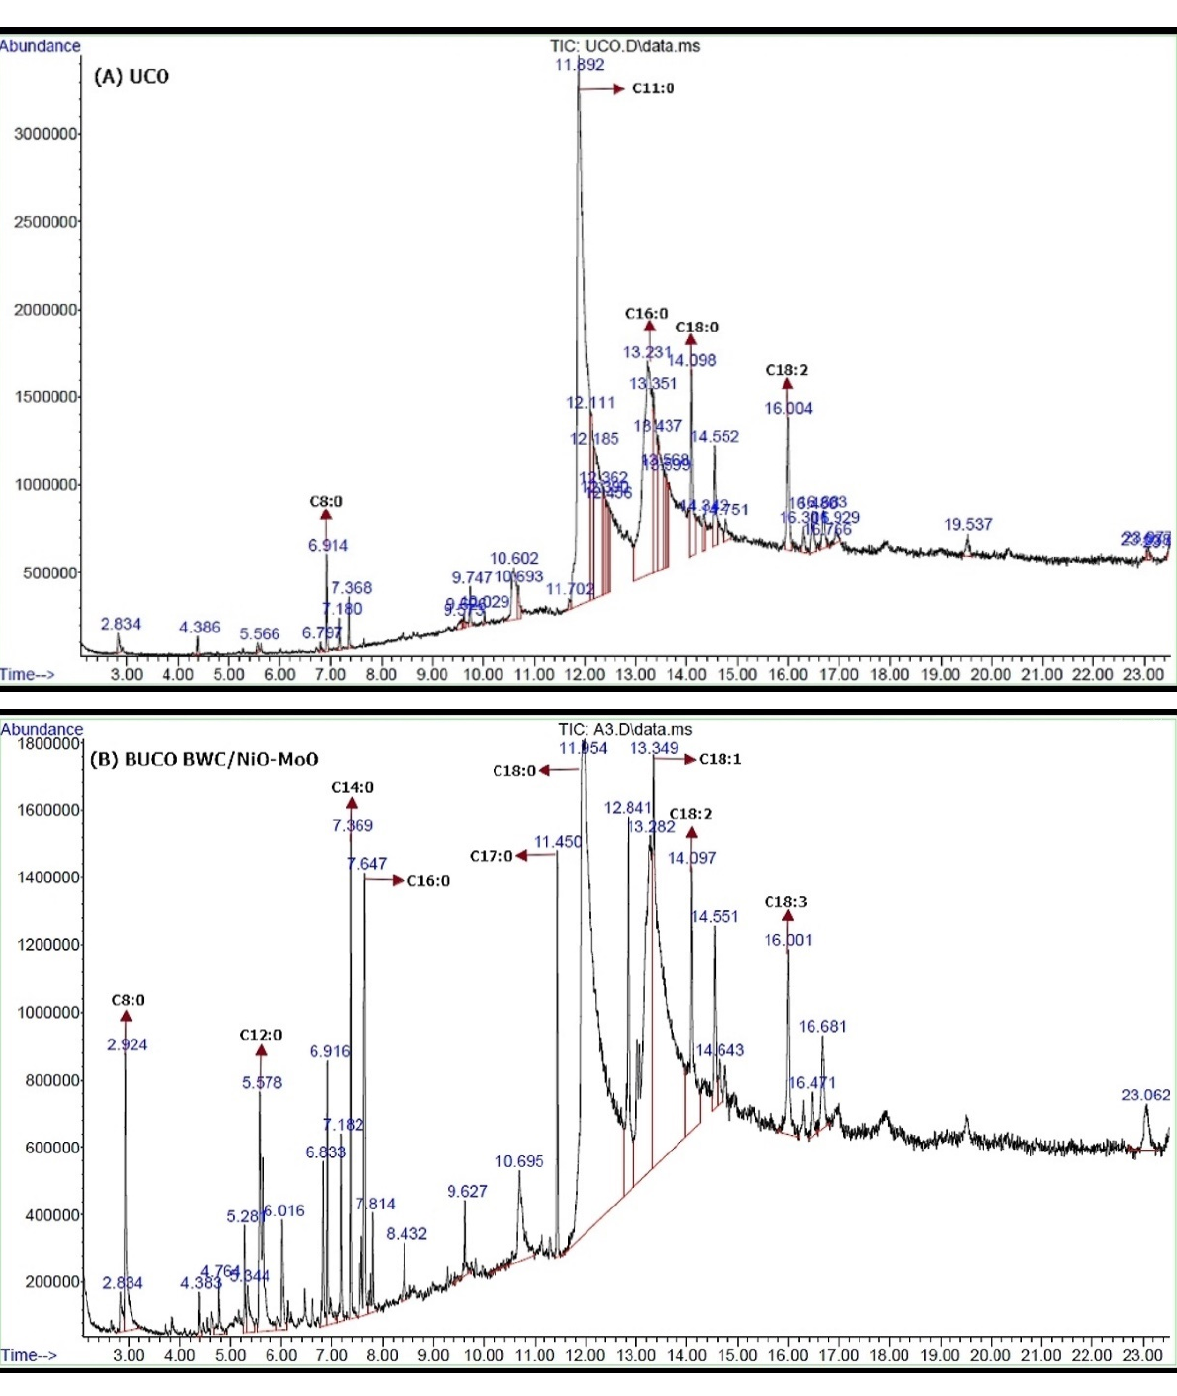
Figure 8. ( A ) Fatty acid profile for UCO, and ( B ) fatty acid profile for biodiesel using BWC/NiO-MoO. Mainly the primary methyl esters such as Octanoic acid (C8), Hexadecenoic acid, Octadecanoic, Oleic acid (C18), Heptadecanoic (C17), Dodecanoic (C12), Nonanoic (C9) acids, etc. were seen in biodiesel. In a similar study, biodiesel produced from waste cooking oil had compounds such as Hexadecenoic acid (C16:1), Octadecanoic acid (C18:1),